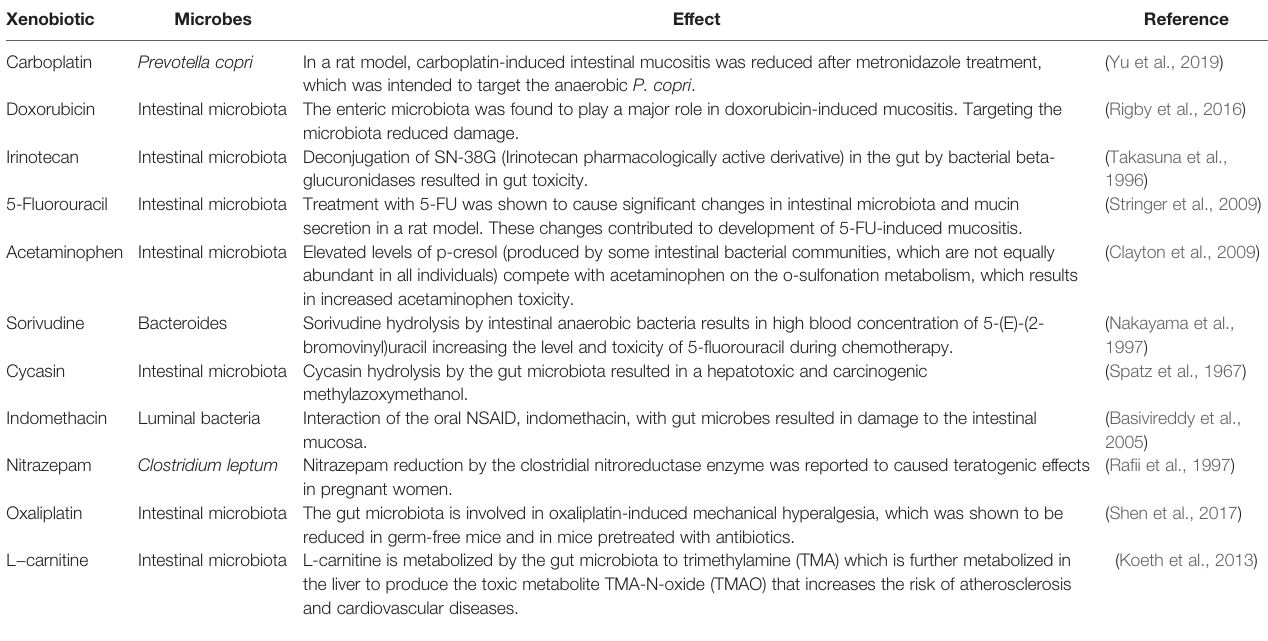
TABLE 2 | Adverse effects/toxicities resulting from xenobiotic-microbiome interactions (pharmaceutical toxicomicrobiomic interactions). Xenobiotic